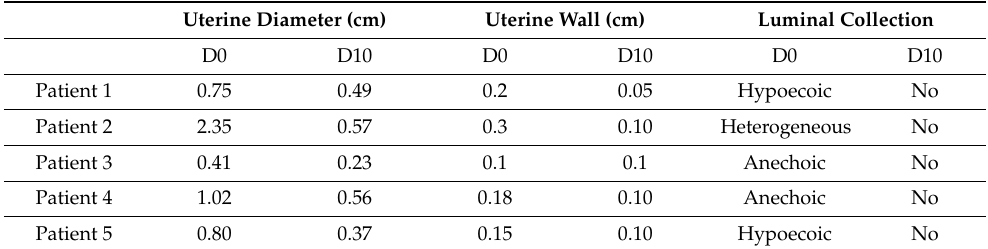
Table 2. Ultrasonographic findings of animals included in the case series. D0 refers to the day of diagnosis and start of aglepristone treatment. D10 refers to the last day of antibiotic treatment, corresponding to the complete ultrasonographic